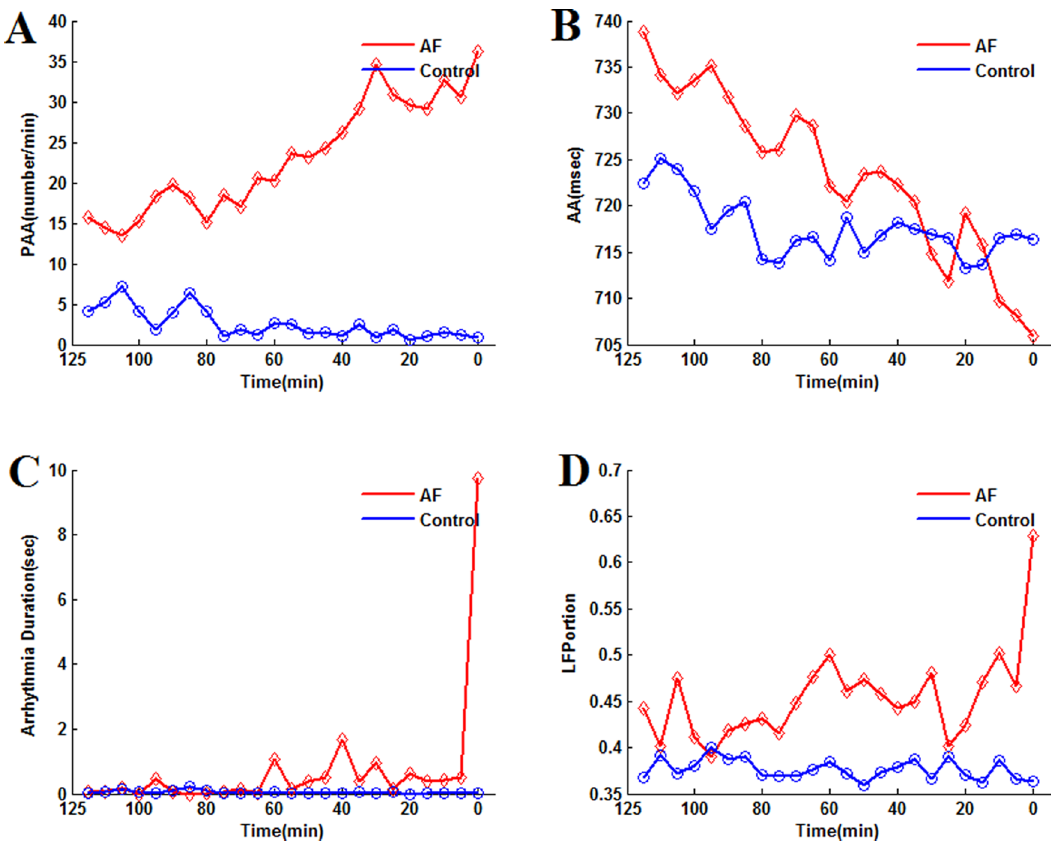
Figure 7. Mean value of PAA rate (A), AA (B), Arrhythmia duration (C), and LFPortion (D) within each 5 minutes for the 2 hours of Control (Non-AF) and AF groups.